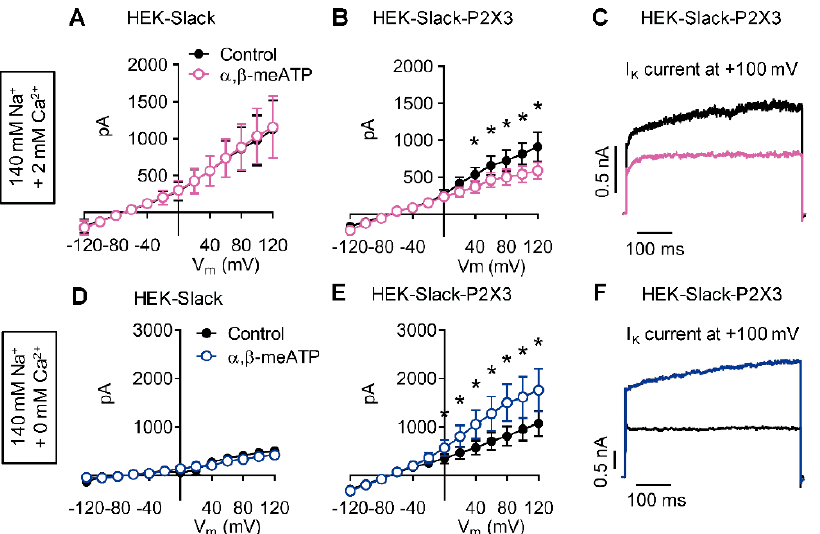
Figure 5. Slack-mediated potassium currents are altered by P2X3 activation in vitro. Representative I K traces from whole-cell voltage-clamp recordings on HEK-Slack and HEK-Slack-P2X3 cells are shown. The current traces presented in ( A – C ) were recorded in the presence of 2 mM CaCl 2 in the external solution ( n = 9–10 cells per group), whereas those depicted in ( D – F ) were recorded after the replacement of CaCl 2 by MgCl 2 ( n = 5–8 cells per group). Experiments were performed without (control) or with the addition of the P2X3 agonist α , β -methylene ATP ( α , β -meATP; 30 µM) to the external solution. Note that the P2X3 agonist exerted opposite effects in HEK-Slack-P2X3 cells dependent on the Ca 2+ concentration: α , β -meATP reduced I K in the presence of Ca 2+ , whereas it increased I K under Ca 2+ -free conditions. Data are shown as mean ± SEM. Student’s t-test, * p < 0.05.